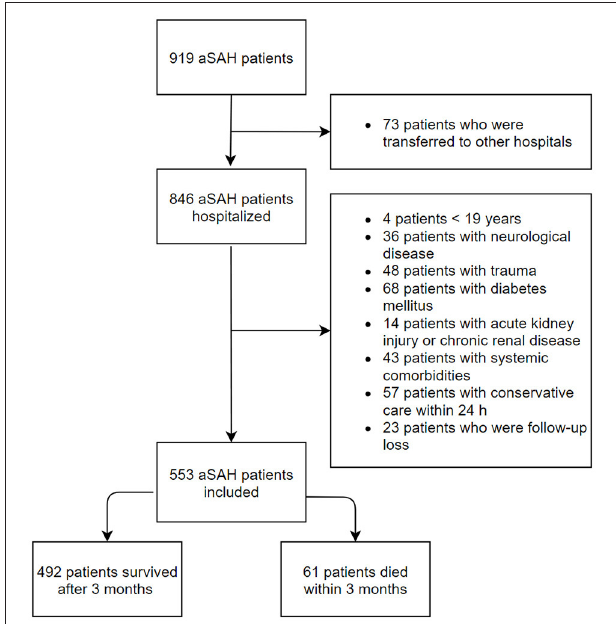
FIGURE 1 | Study population flow